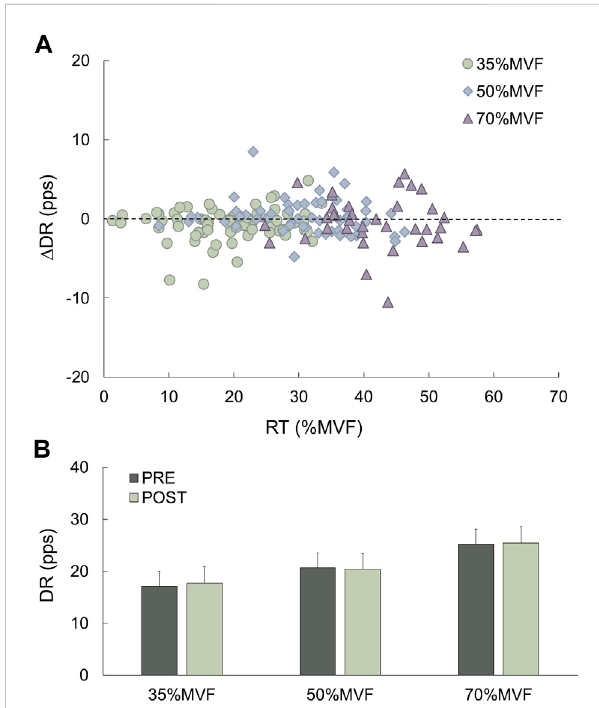
FIGURE 8 Difference in motor unit discharge rate (Pre- and Post-WBV) relative to normalized recruitment threshold after the exposure. (A) The difference in the discharge rate (ordinate) as a function of the recruitment threshold after the intervention in the WBV group. (B) Bar plot of the overall discharge rate changes. Data are reported as mean ±